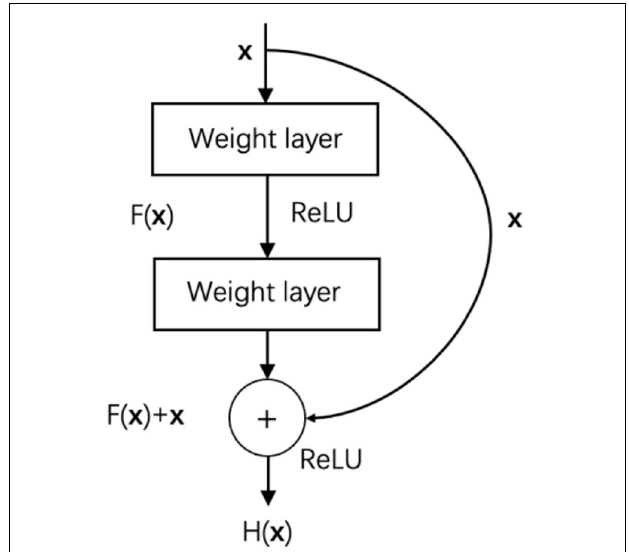
FIGURE 6 | Residual